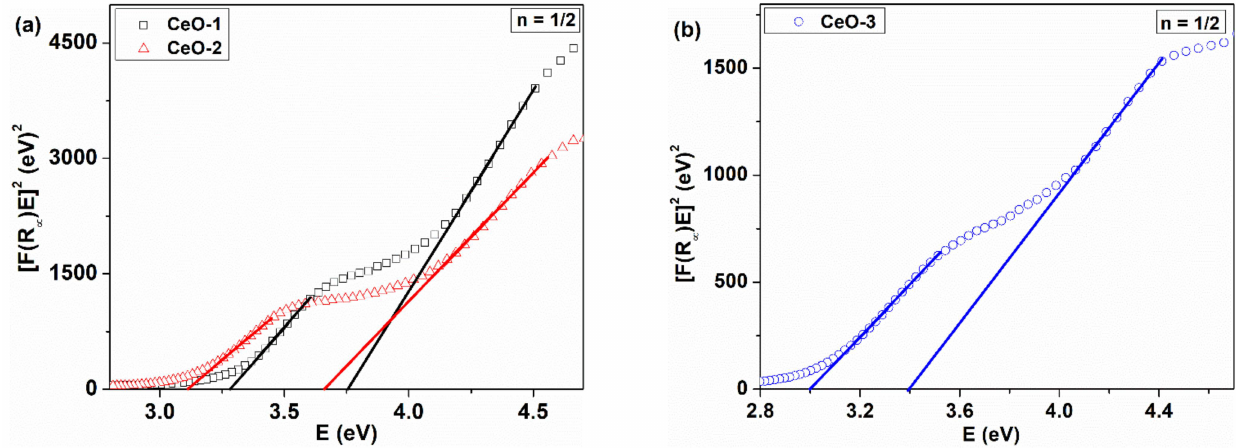
Figure 6. [F(R)h ν ] 2 versus h ν plots of CeO 2 nanoparticles: ( a ) CeO-1 and CeO-2, ( b ) CeO-3.